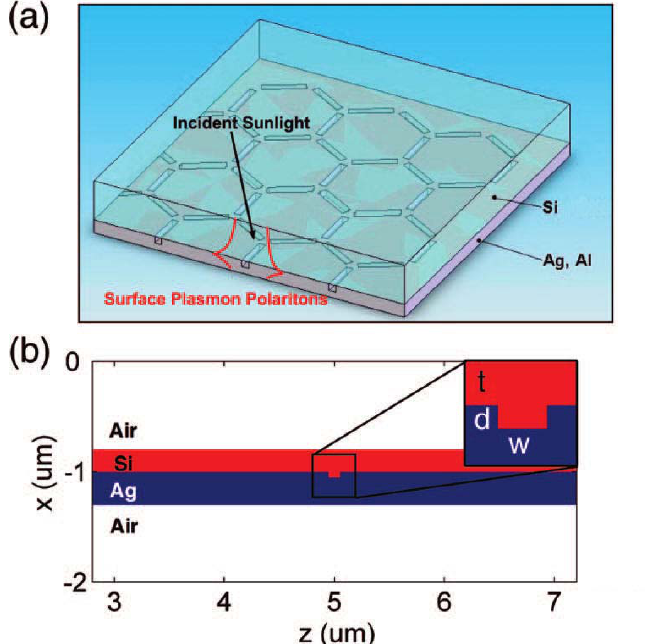
Figure 7. (a) A three-dimensional scheme of a SC with subwavelength grooves tiled on a back Ag contact. (b) The schematic outline of the device layer in the discussion. The constants here are t = 200 nm (thickness of silicon layer), d = 50 nm (depth of a Ag groove), and w = 100 nm (width of a Ag groove) (reprinted with permission from [40]. © 2008, American Chemical Society).